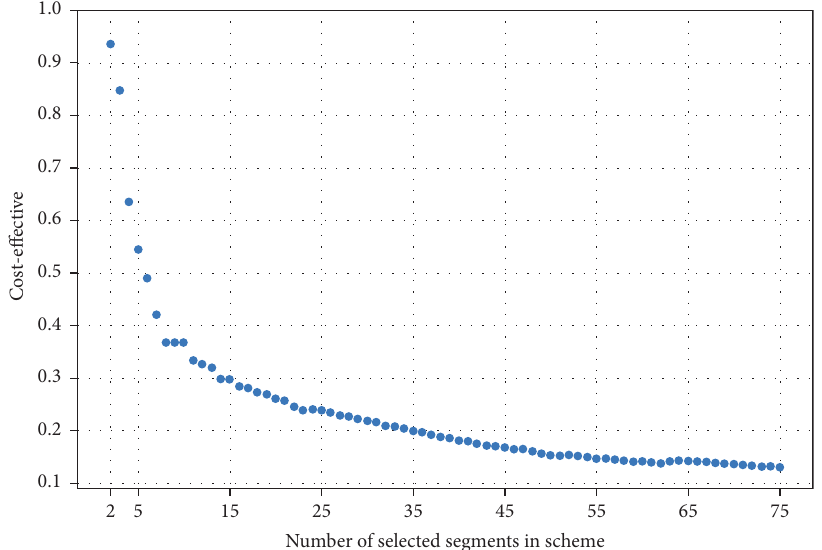
Figure 9: Cost-efficiency of the